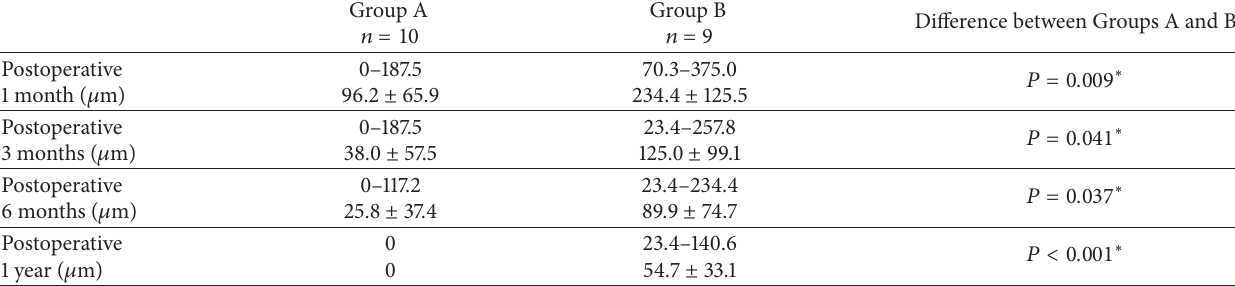
Table 2: Diameter of EZ disruption.